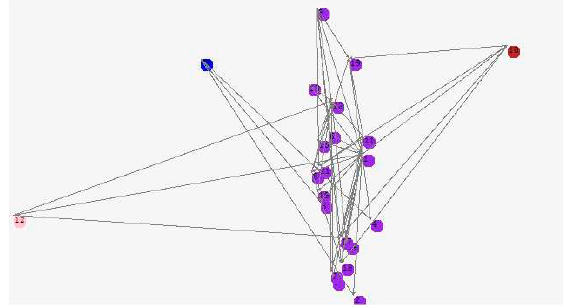
Fig. 1. Example of a web social